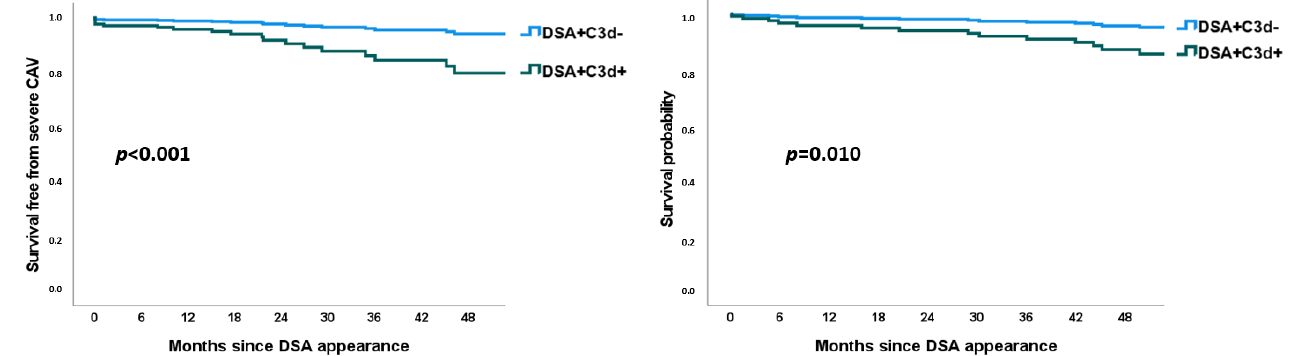
Figure 3. Adjusted Cox regression survival curves. Adjustment with recipient sex, recipient age, CMV status at transplantation, number of cellular rejection episodes ≥ grade 2, total number of mis- matches, creatinine at time of coronary angiography, and ejection fraction at time of coronary angi- ography. CAV = cardiac allograft vasculopathy; DSA = donor specific antibodies.